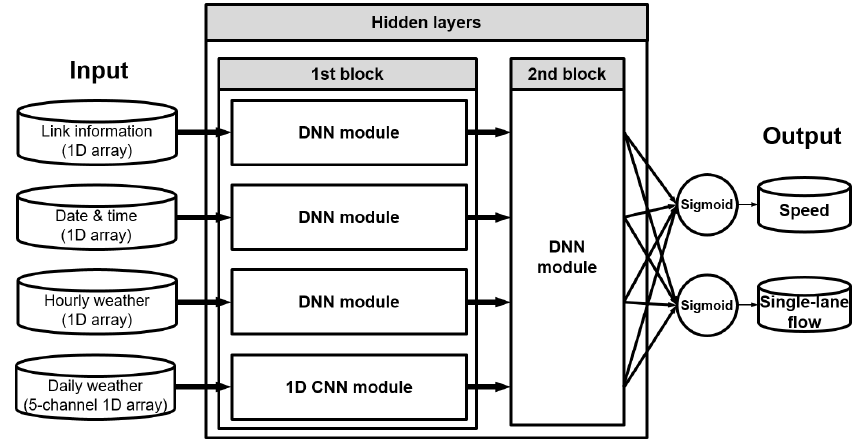
Figure 2. Structure of the initial traffic predictor.